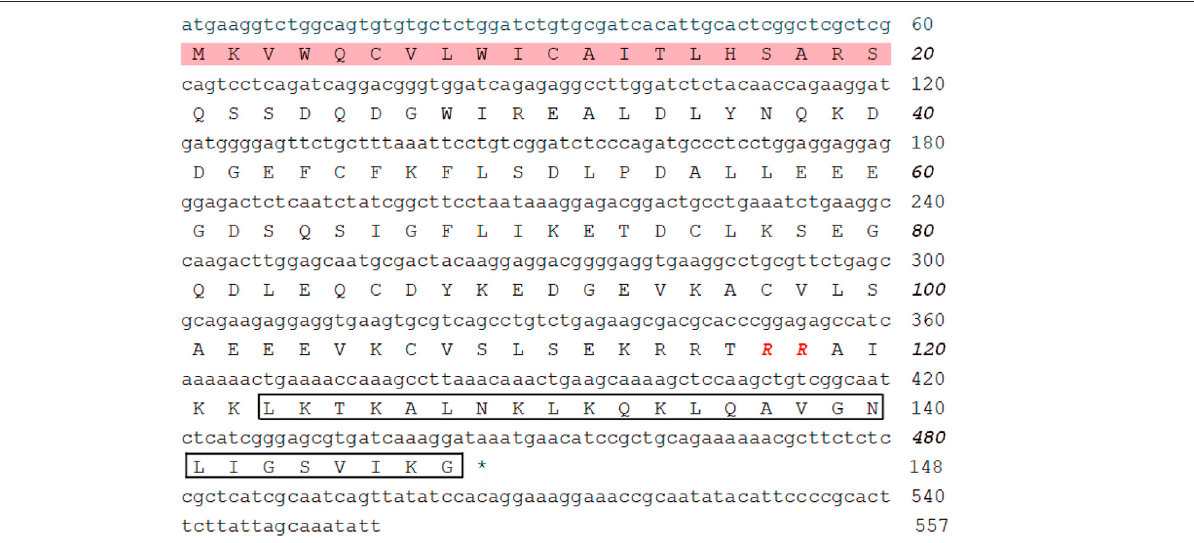
FIGURE 1 | The nucleotide and the deduced amino acid sequences of FM-CATH. The signal peptide is framed in pink and followed by a cathelin-like domain with RR residues at the end in red bole. The sequence of mature FM-CATH is boxed, and the stop codon is displayed by * .